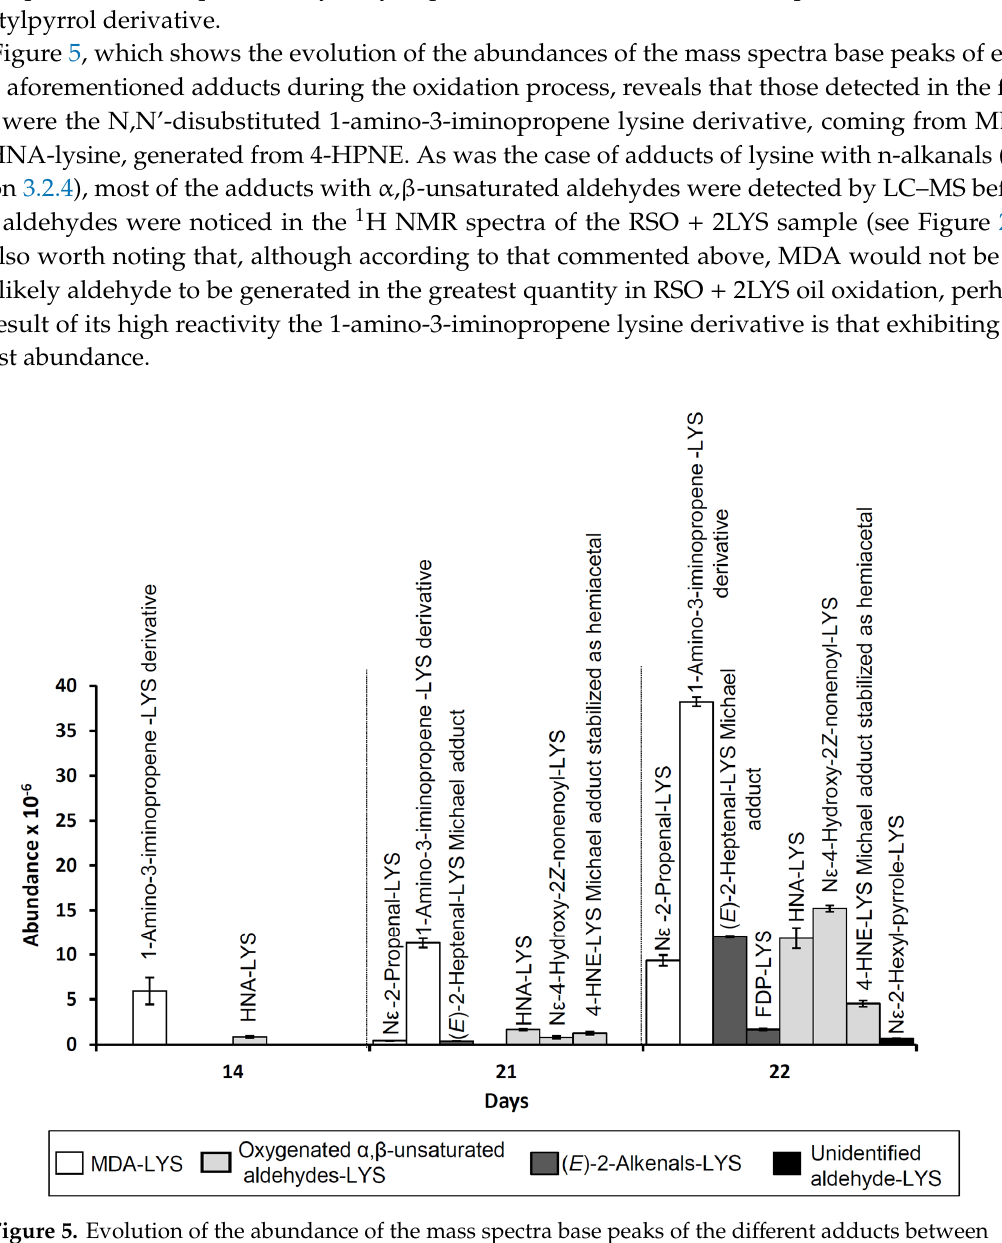
Figure 5. Evolution of the abundance of the mass spectra base peaks of the di ff erent adducts between lysine and other aldehydes di ff erent from n-alkanals in the aqueous extracts of the RSO + 2LYS sample obtained throughout the oxidation process, determined by LC–MS. All the figures reported are mean values. LYS: lysine; MDA: malondialdehyde; 4-HNE: 4-Hydroxy-( E )-2-nonenal.